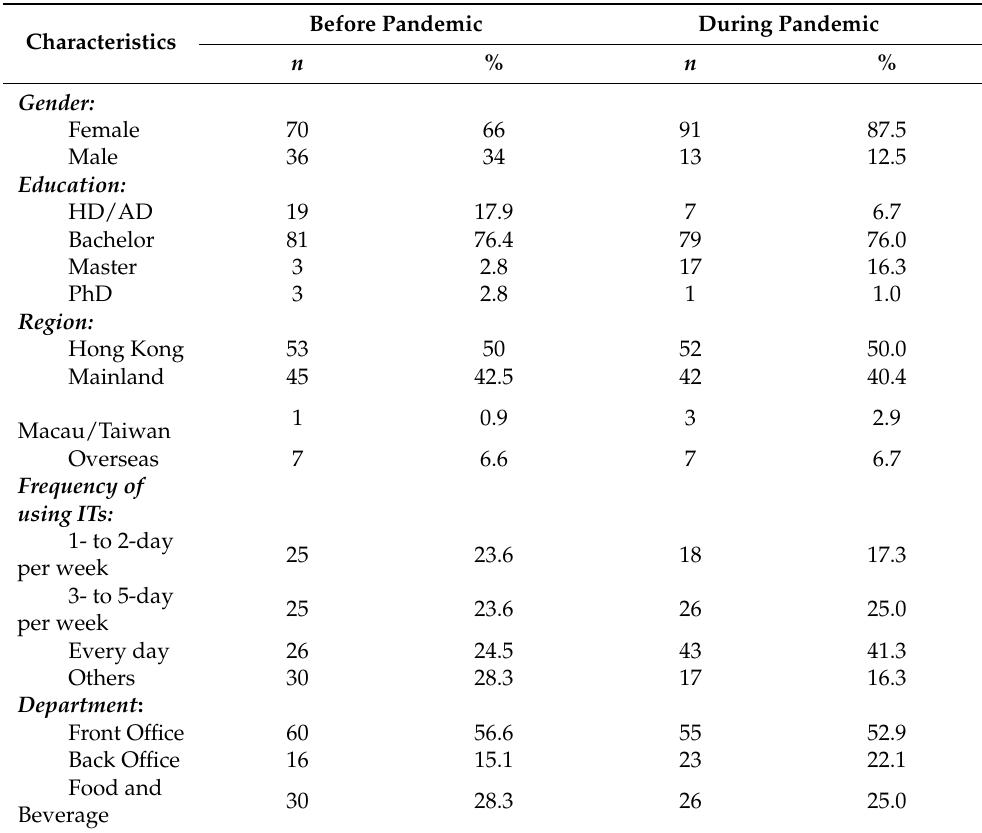
Table 3. Demographic characteristics of